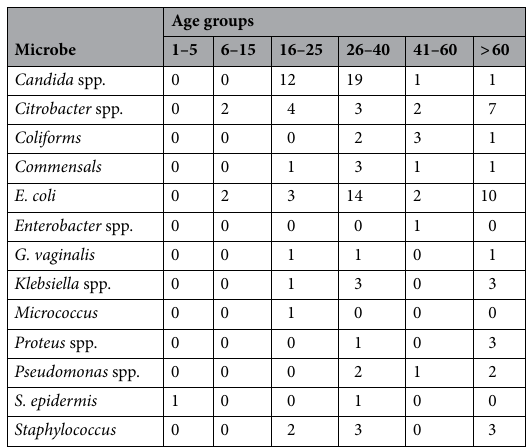
Table 4. Individual bacteria identified in samples per age groups.